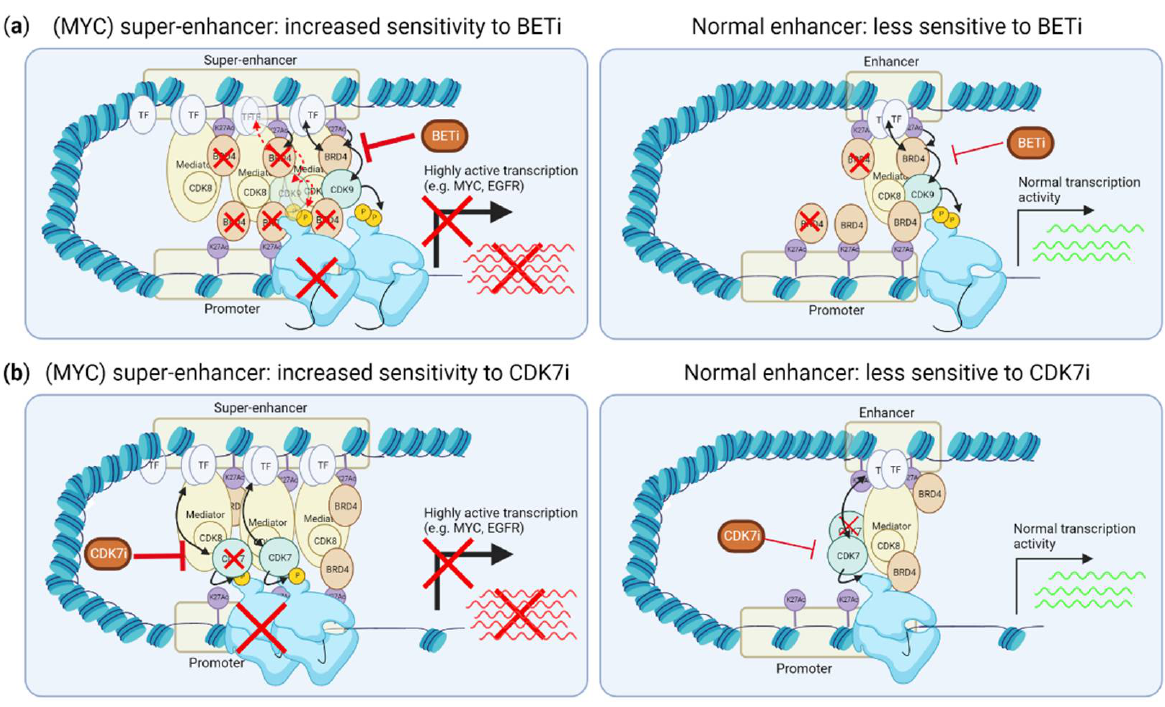
Figure 3. Effects of CDK7 and BET inhibition on super-enhancer driven transcription. ( a ) BRD4 is enriched at super-enhancers, and its inhibition preferentially disrupts this enrichment and expression driven by super-enhancers, not normal enhancers. ( b ) CDK7 inhibition preferentially reduces RNA polymerase II binding to the transcription start site of genes driven by super-enhancers. This figure was created with BioRender.com (accessed on 8 August 2022).